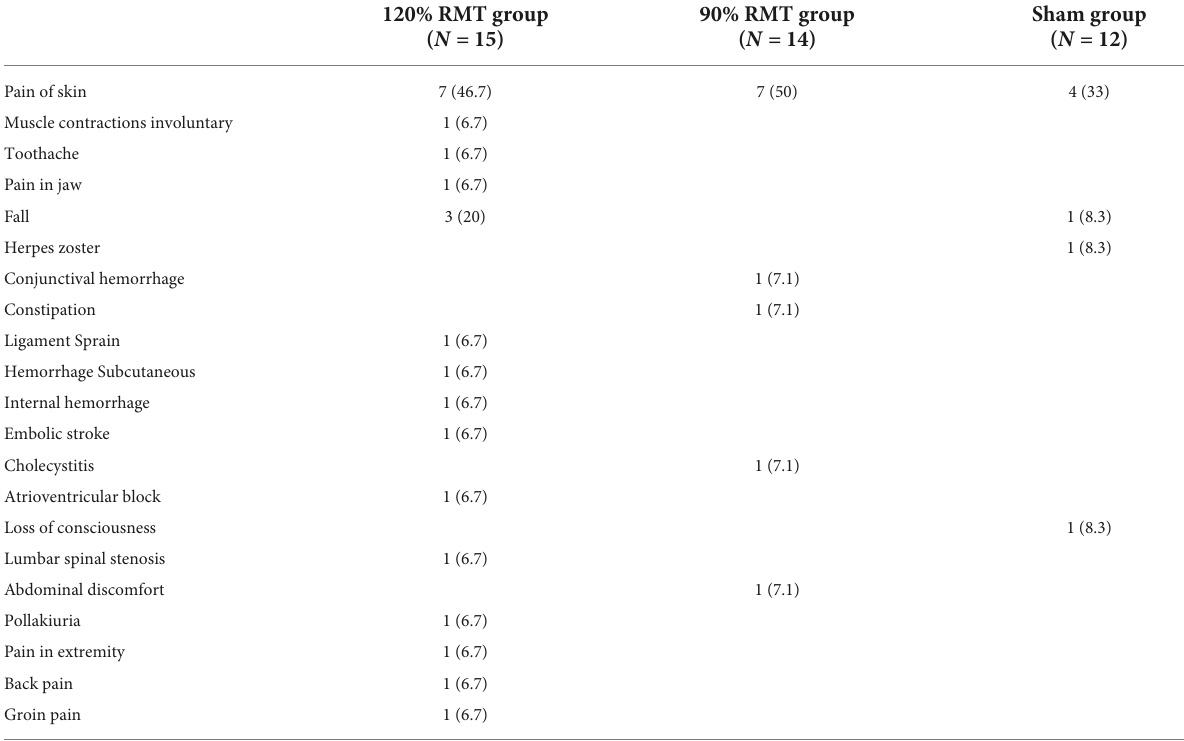
TABLE 3 Adverse